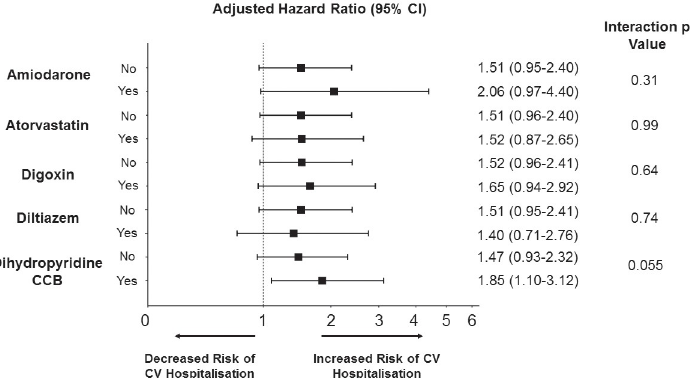
Fig 2. Risk of CV hospitalization at 14 days stratified by concomitant P-glycoprotein medication prescription. Hazard ratio adjusted using the likelihood of clarithromycin prescription as a covariate (inverse probability of treatment weighting)—this included the following variables: age at prescription, sex, prior history of chronic obstructive pulmonary disease, prior myocardial infarction, history of type 2 diabetes, left ventricular systolic function impairment, and all medications listed in Table 1. CCB, calcium channel blocker; CI, confidence interval; CV, cardiovascular.